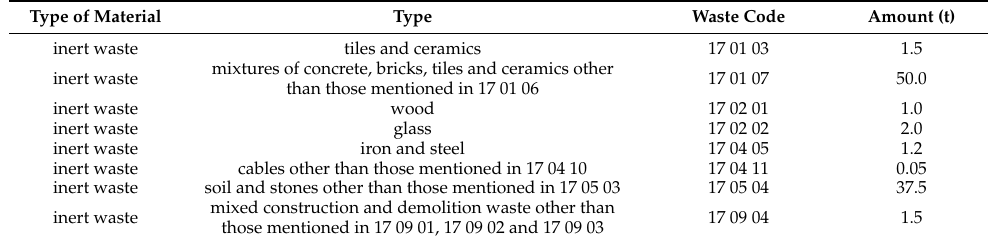
Figure 6. Photo documentation of the construction during the site visit. Table 8. Inventory of construction and demolition